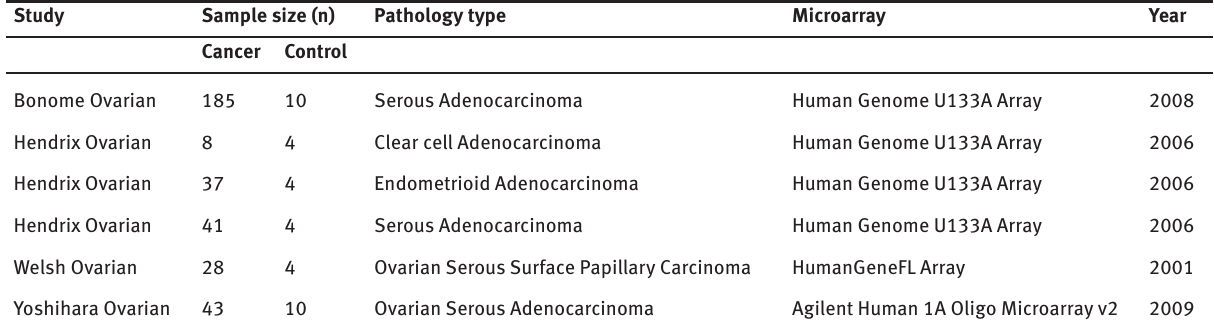
Table 1: Characteristics of the included six studies. Study